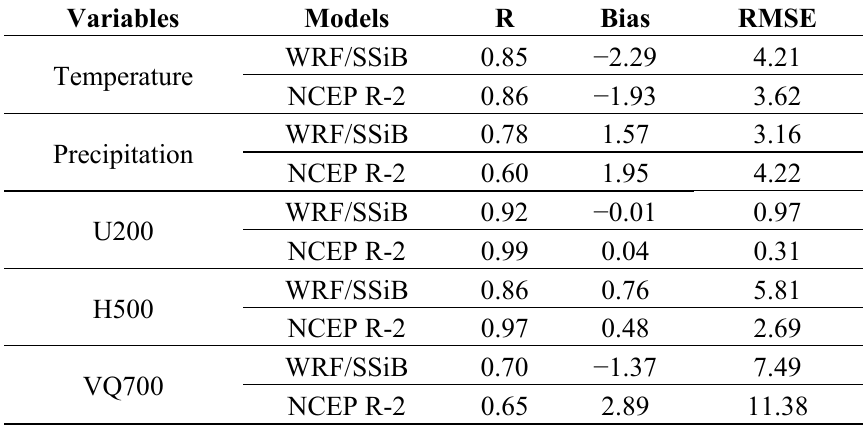
Table 2. Comparison between WRF/SSiB simulations and NCEP R-2 for ensemble mean